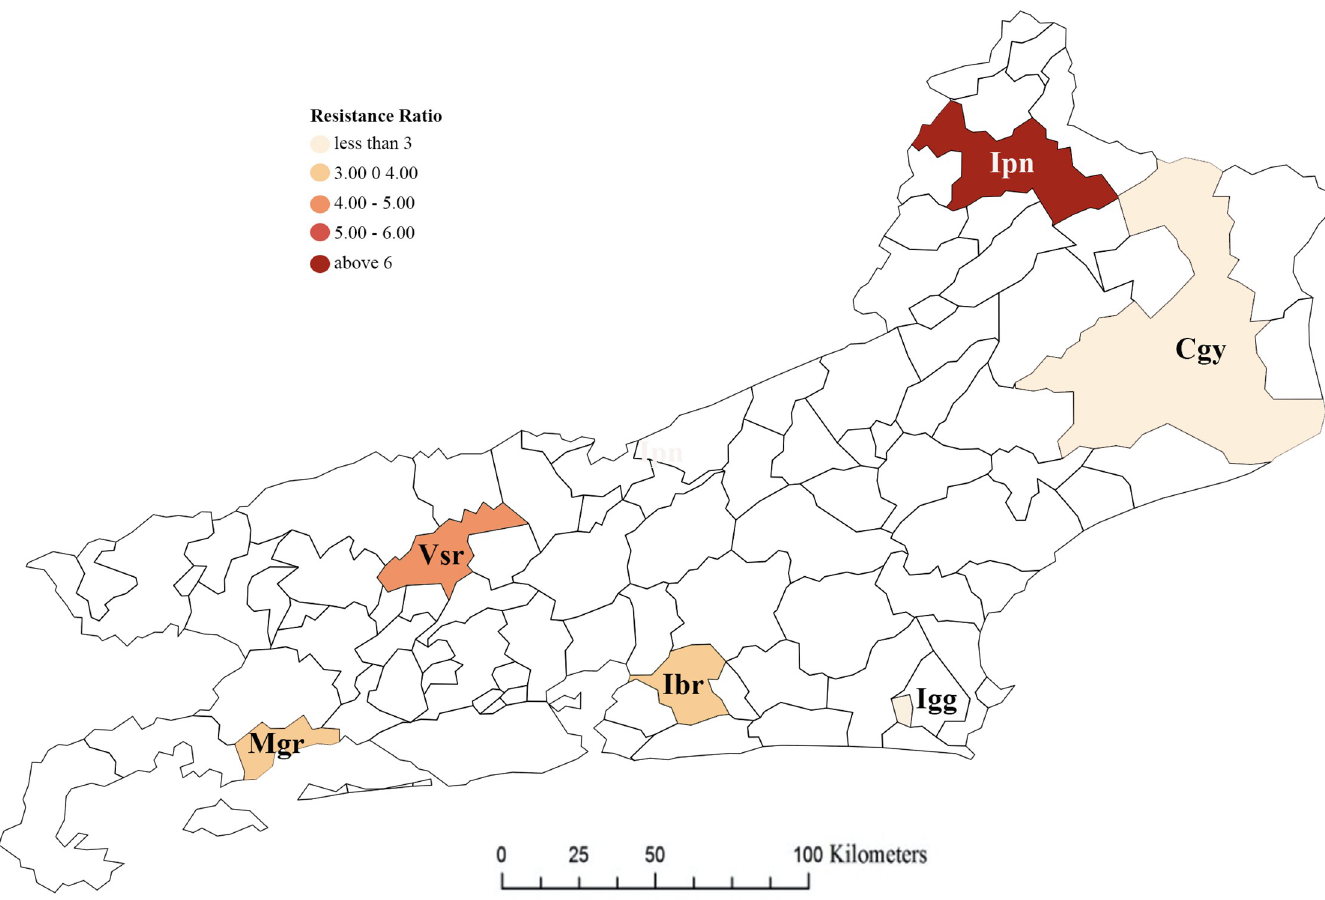
Fig 2. Resistance ratios (RR 50 ) to temephos in Aedes aegypti populations from Rio de Janeiro State, Brazil. We obtained the RR 50 after calculating the lethal concentration (LC 50 ) of each population and comparing it with the LC 50 of the reference